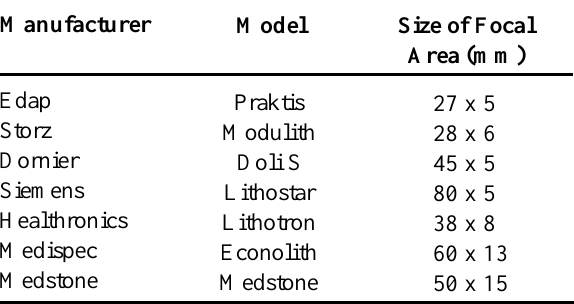
Table 5 – Lithotripter focal